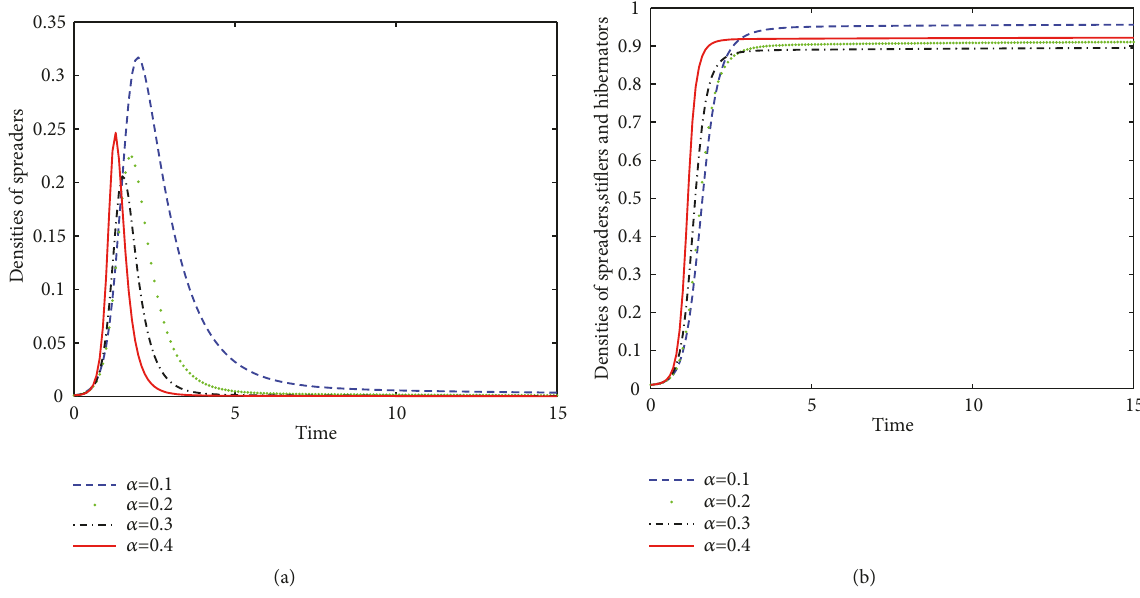
Figure 8: Numerical simulations of (3) with 𝜆 = 0.6 , 𝛽 = 0.3 , 𝛿 = 0.2 , 𝜉 = 0.1 , and 𝜂 = 0.2 and different stifling rates 𝛼 in the network with the Poisson degree distribution. (a) The trajectories of the densities of spreaders. (b) The trajectories of the densities of spreaders, stiflers, and